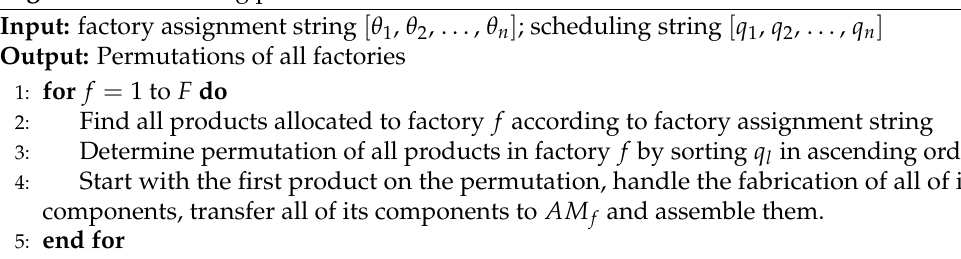
Algorithm 1 Decoding